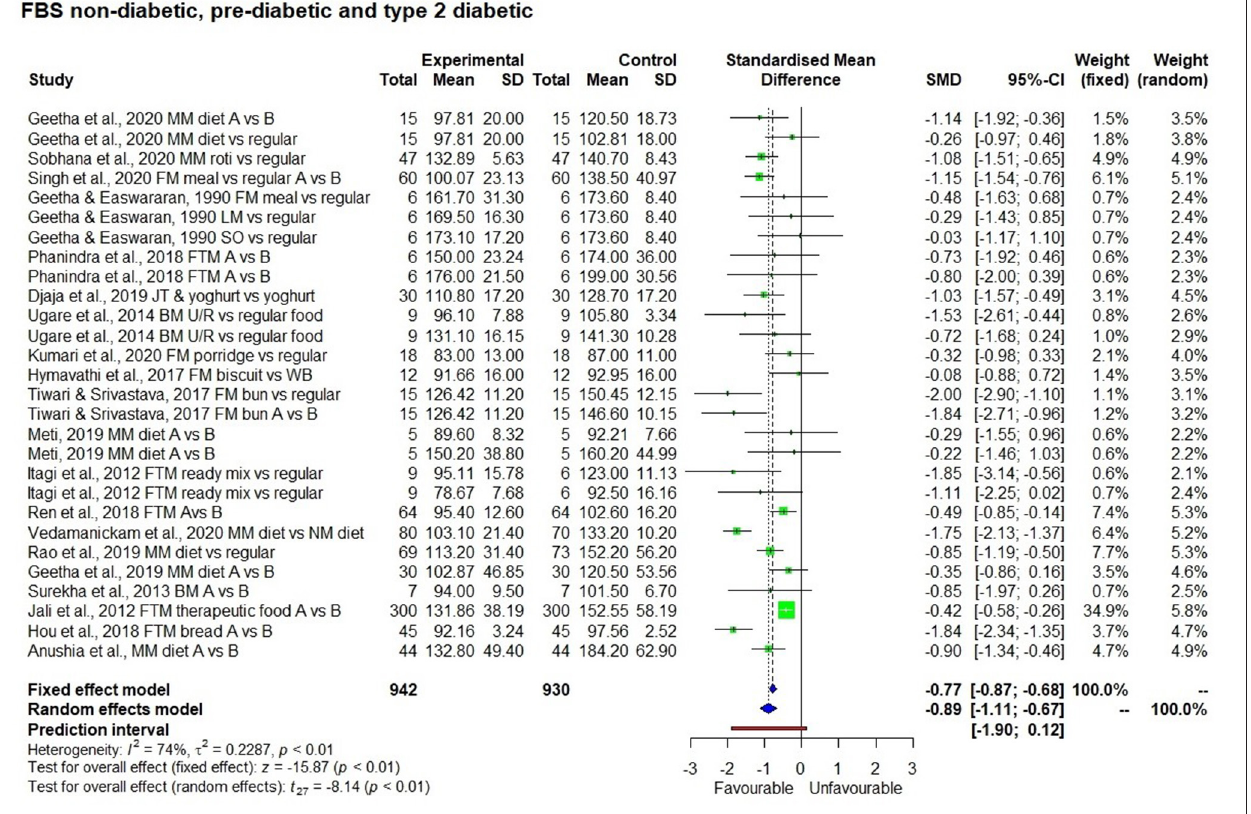
boiling increased the GI of the food by up to 18.4 units, 16.3